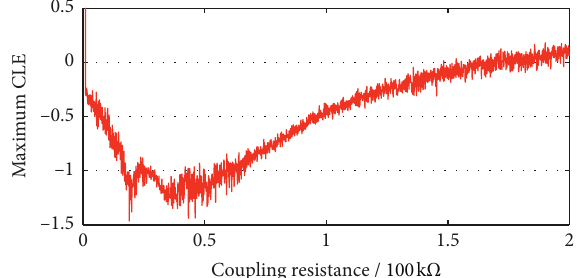
Figure 11: Maximum CLEs of the error system (14) with only resistive coupling.